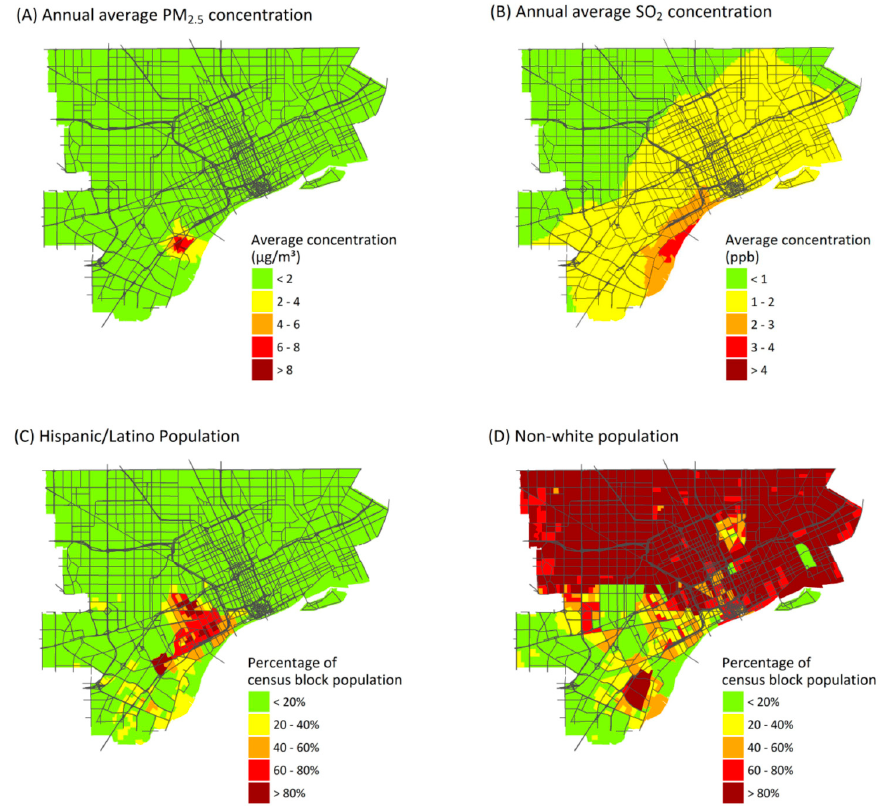
Figure 3. Annual average ambient concentrations from point sources of: PM 2.5 ( A ); and SO 2 ( B ). Percentage of the population identifying as: Hispanic or Latino ( C ); or as persons of color (excludes non-Hispanic whites) ( D ).